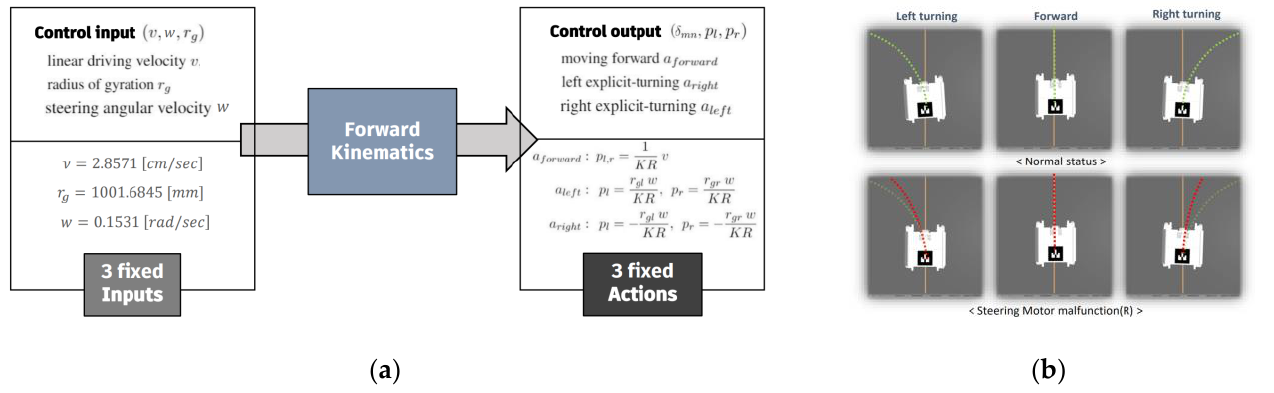
Figure 19. Approximated forward kinematics used for rover locomotion control in the DQN. ( a ) Parameter setting input to define three fixed actions. ( b ) Gyration paths for the rover’s three actions in a normal state (upper) and in steering motor malfunction (lower).